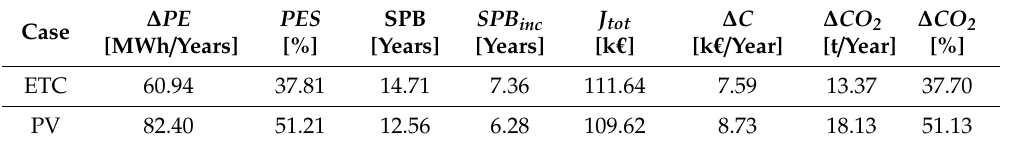
Table 7. Yearly energy, economic and enviromental results.